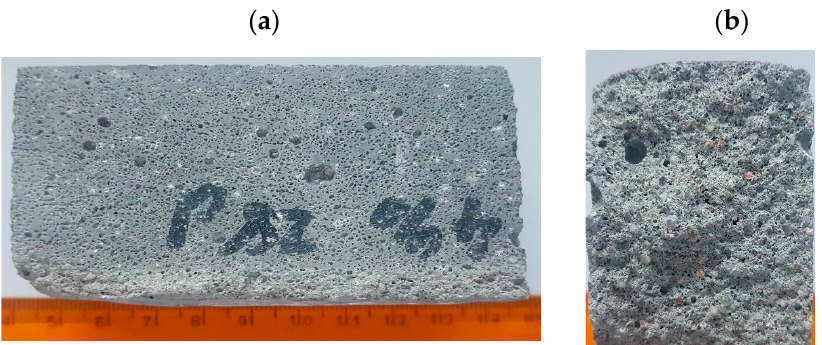
Figure 5. Cement mortar with the addition of 18% fly ash from the MSWI plant (CEM I + 18% FA): ( a ) outer surface; ( b ) internal structural view.